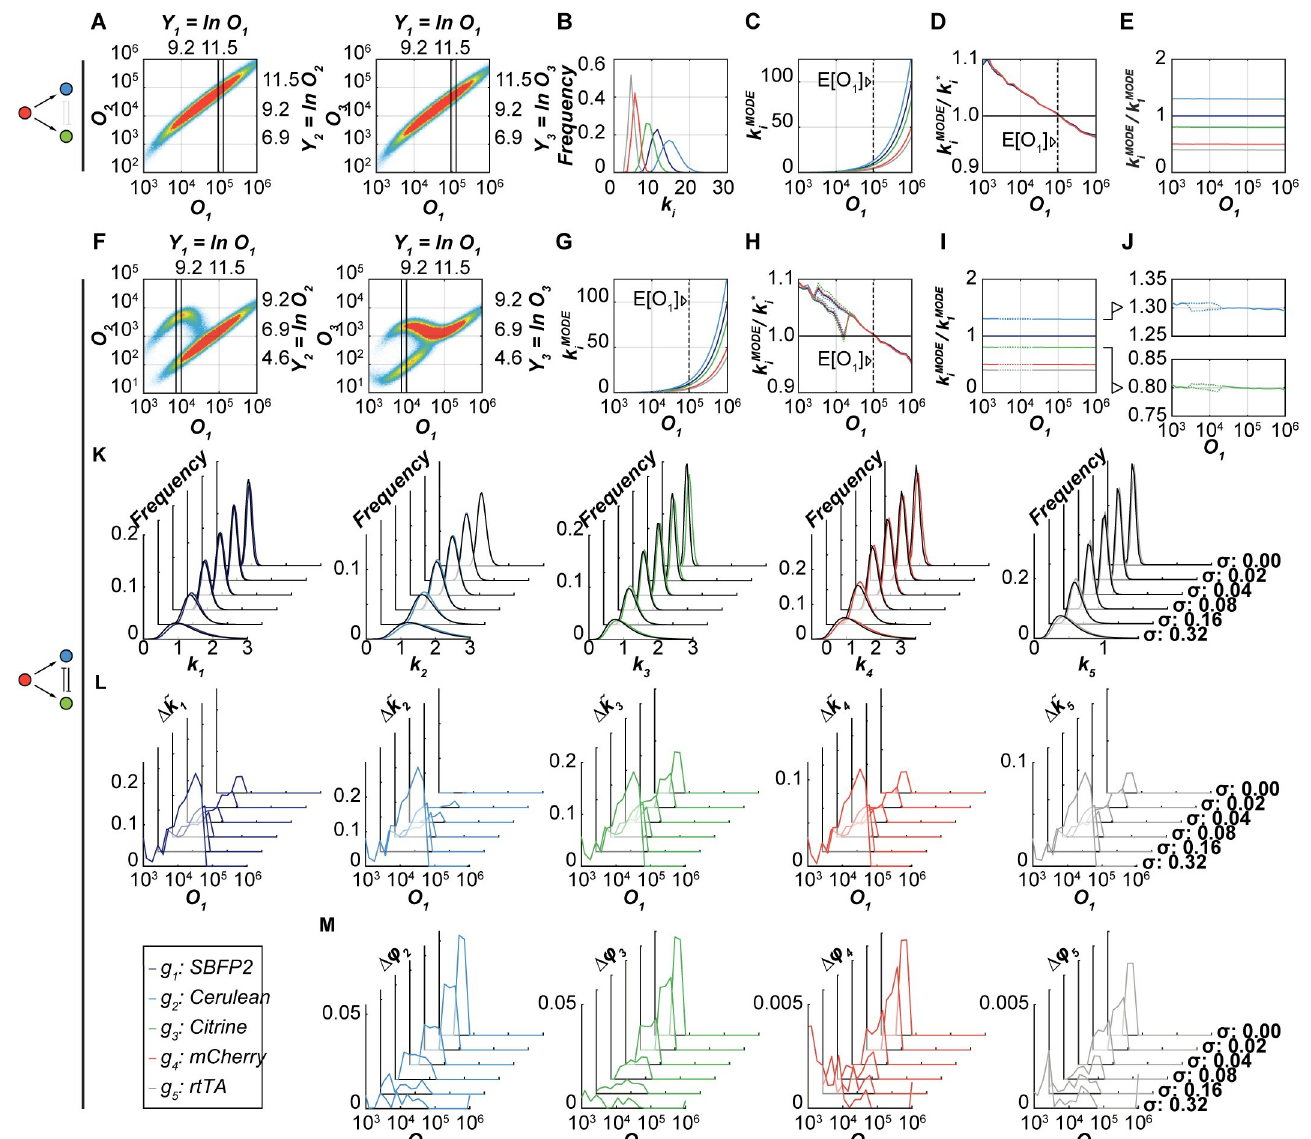
Fig 3. In-silico simulation of transiently-transfected gene circuits FO and RIFFM and the copy number analyses at various σ noise levels. In-silico simulations (global parameters σ = 0.08, ε = 0.04, μ m = 1.4979, σ m = 1.2686 and a 1 : a 2 : a 3 : a 4 : a 5 = 1.0: 1.3: 0.8: 0.5: 0.4) shown for two circuits: A-E monomodal/fan-out (FO) and F-M bi-modal (RIFFM). (A) Raw data of the simulated transiently transfected FO circuit. The amount of expressed proteins O 2 (left: Cerulean) or O 3 (right: Citrine) versus O 1 (transfection marker: SBFP2) is shown as a density plot. Solid lines indicate the edges of a transfection marker bin. (B) Gene copy number distributions of cells binned by a particular value of log-transformed O 1 in a bin shown in panel A . (C) The modes of the copy number distributions, k MODE , are i plotted versus the median signal of the transfection reference protein O 1 for all bins (colored lines). The dash-dotted line marks the mean ( E [ O 1 ]) of the global O 1 distribution. (D) The ratio of the numerically-determined mode of the copy number distribution k MODE and the anticipated copy number k � plotted versus the O 1 i i values in individual bins. The global mean of O 1 is shown with a dash-dotted line. (E) Modes of the gene copy number distributions k MODE normalized by the mode i of the transfection reference gene k MODE are shown as a function of O 1 values in individual bins. (F) Raw data of the simulated RIFFM circuit with bi-modal output 1 O 2 (Cerulean; left) or O 3 (Citrine; right). The black lines indicate a bin within the bimodal range. (G) The modes of the copy number distributions, k MODE ; HIGH i and k MODE ; LOW i , are plotted versus the median signal of the transfection reference protein O 1 of all bins (colored lines). Dashed segments indicate the range of O 1 in which the high and low modes do not coincide; the black dash-dotted line indicates the mean ( E [ O 1 ]) of the global O 1 distribution. (H) The ratios of the numerically-determined mode of the copy number distribution k MODE ; HIGH and k MODE ; LOW ; and the anticipated copy number k � are plotted versus the corresponding i i i O 1 values in individual bins. Dashed segments indicate the range of O 1 in which the ratios corresponding to high and low modes do not coincide. The global mean of O 1 is shown with a straight dash-dotted line. (I) Modes of the gene copy number distributions k MODE ; HIGH and k MODE ; LOW , normalized by the mode of the i i transfection reference gene k MODE are shown as a function of O 1 values in individual bins. Dashed lines indicate the range of O 1 where the values do not coincide. 1 (J) The ratios k MODE = k MODE depicted in panel I are shown in greater detail for the outputs O 2 (Cerulean; top) and O 3 (Citrine; bottom). (K) Fitted gene 1 i